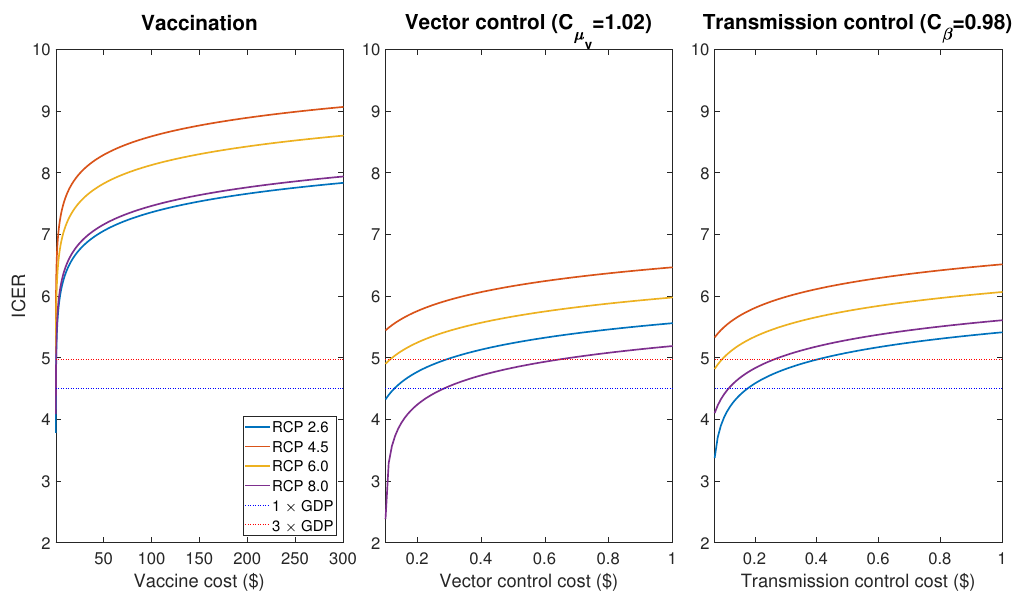
Figure 11. Incremental cost-effectiveness ratio (ICER) in log 10 scale for the vaccinate, vector control and transmission control